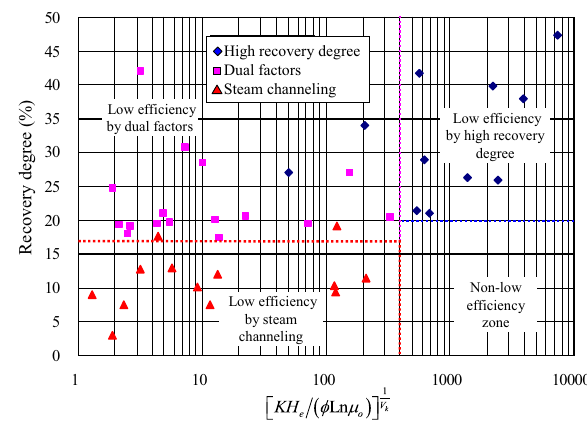
Fig. 2 The diagram of classification standard for low